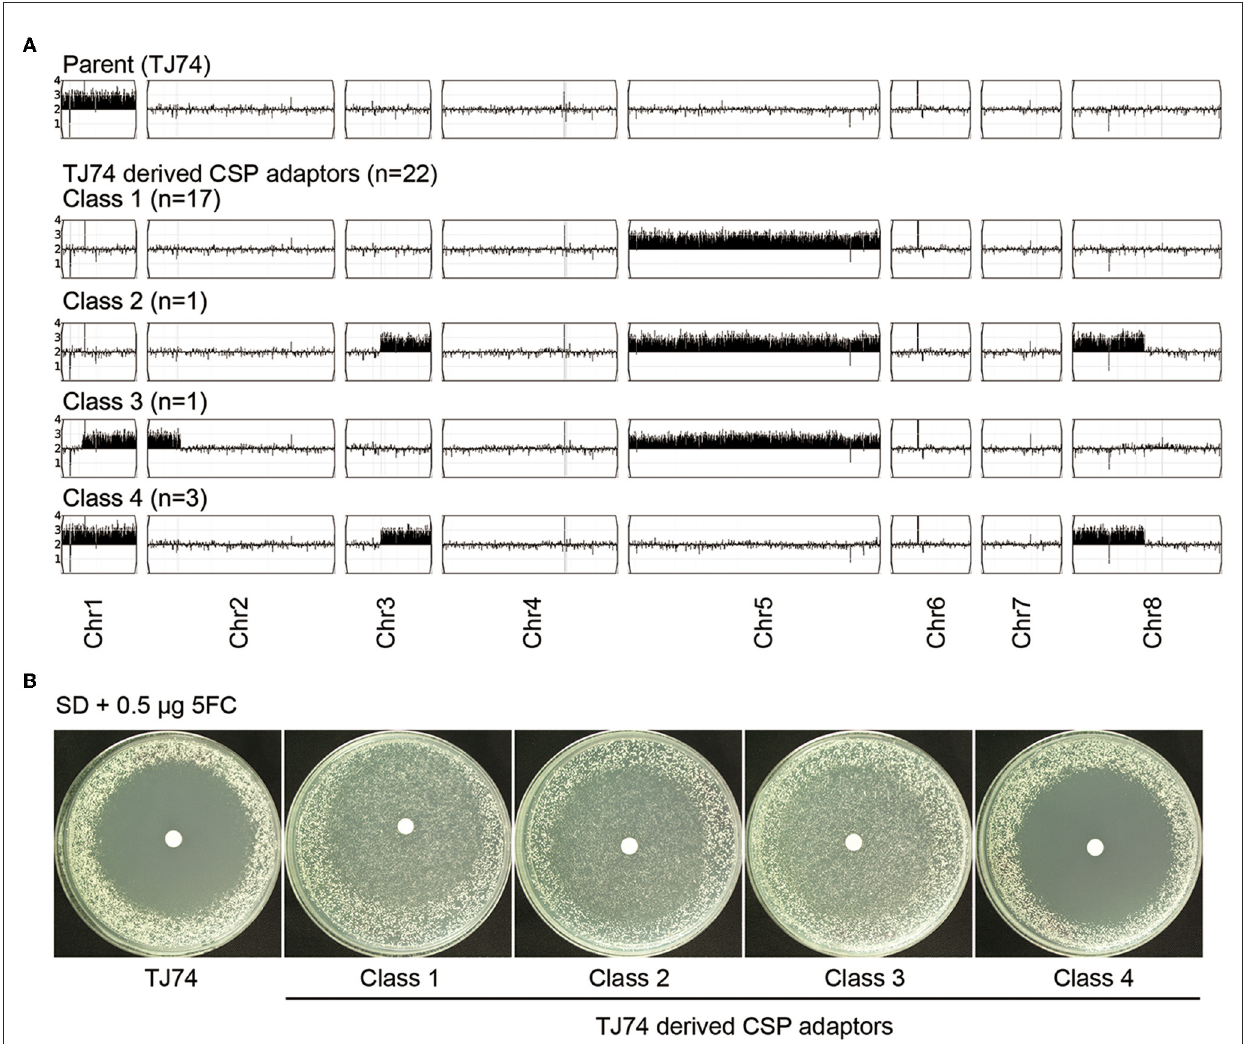
FIGURE6 Adaptation of chromosome 1 trisomy strain to caspofungin. One chromosome 1 trisomy strain, TJ74, was spread on the YPD plate supplemented with 400ng/ml caspofungin (CSP). Twenty-two out of 30 adaptors randomly chosen gained tolerance to CSP. All 22 tolerant adaptors were sequenced. Based on the pattern of aneuploidy, the adaptors were divided into four classes (A) . Each class was tested for tolerance to 5-flucytosine (5FC) by disk diffusion assays. Only adaptors with Chr5x3 were tolerant to 5FC (B)